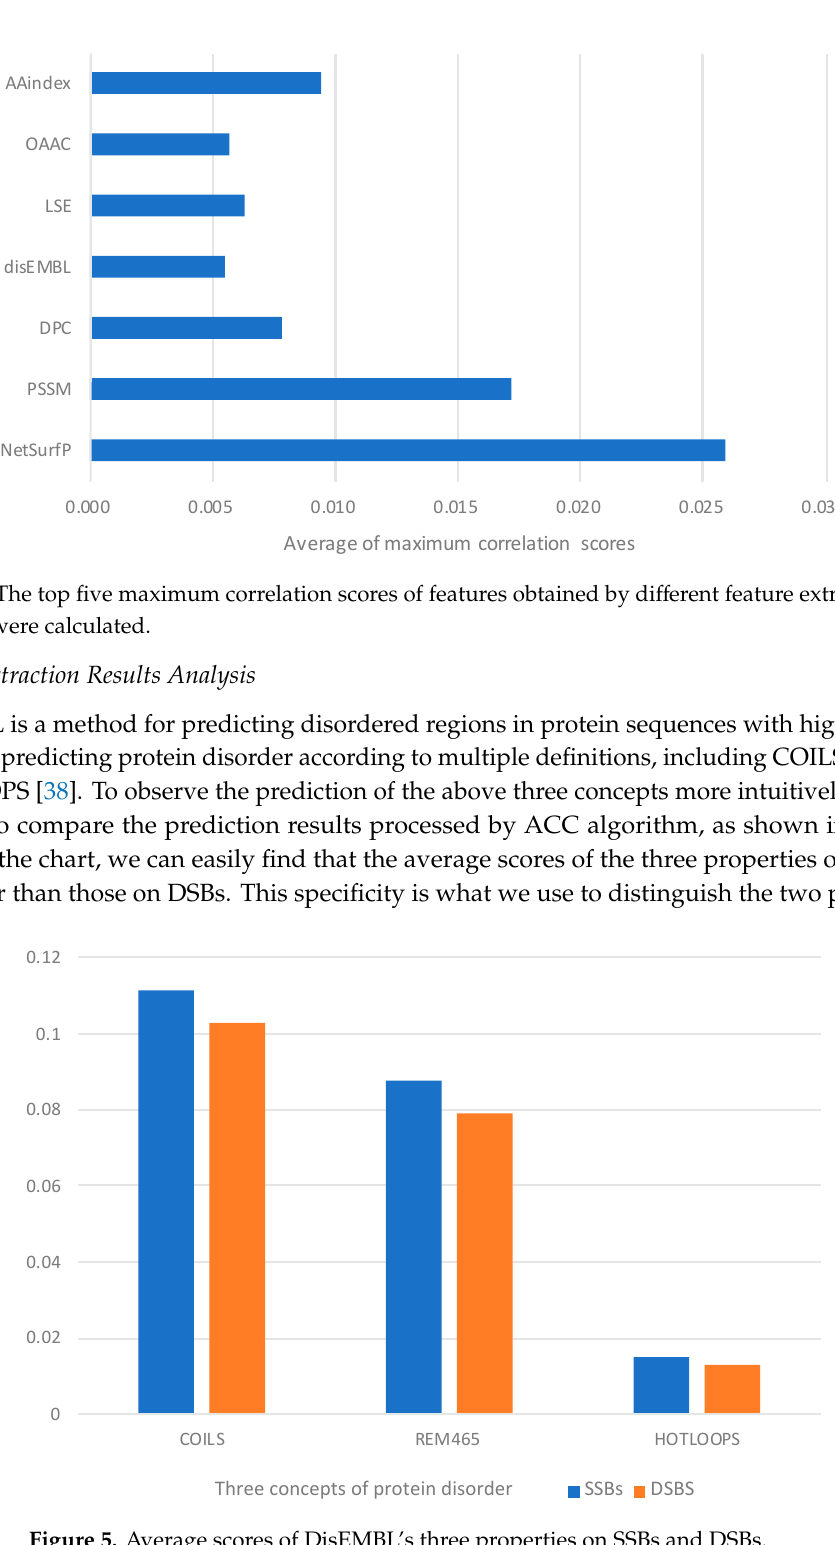
Figure 5. Average scores of DisEMBL’s three properties on SSBs and DSBs.